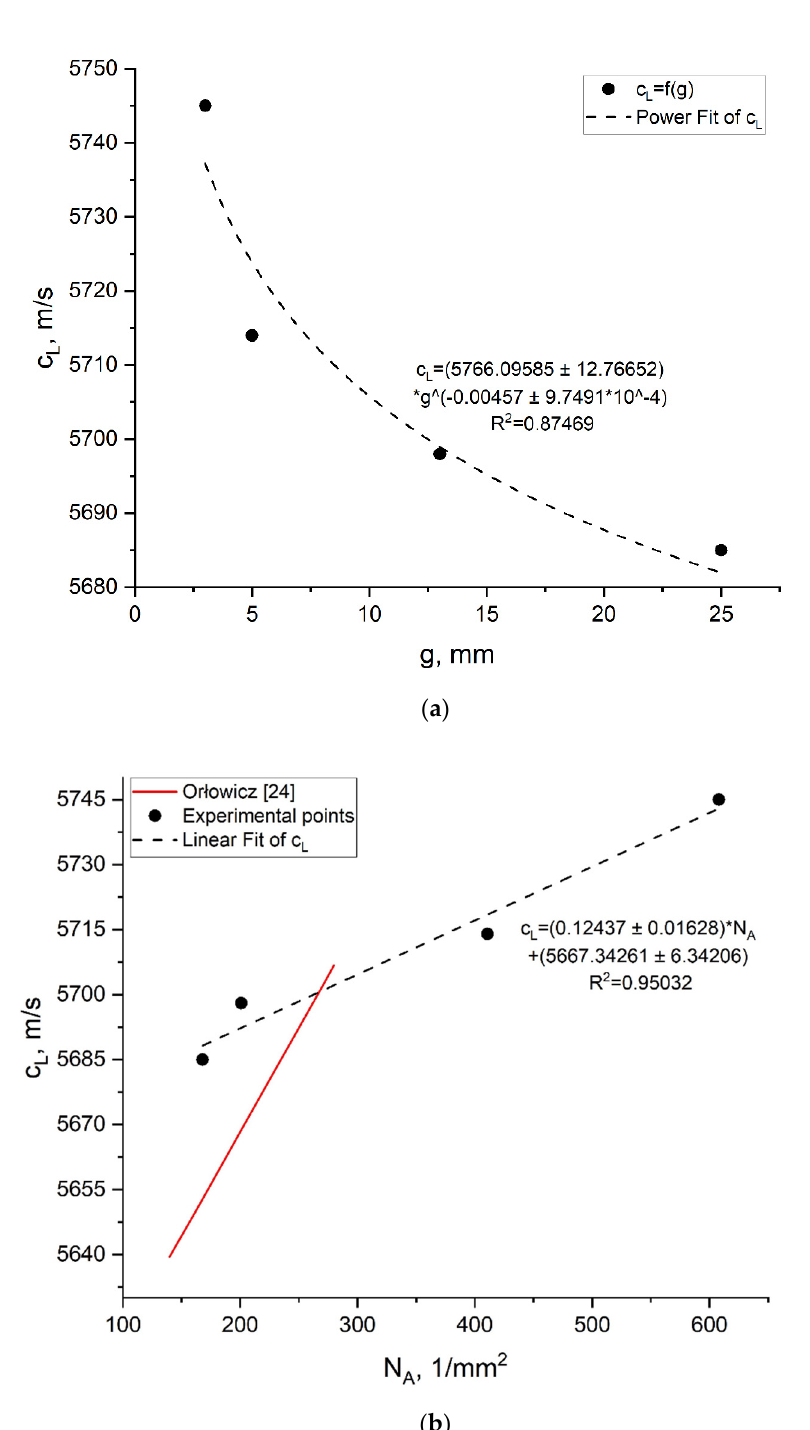
Figure 10. Relationship between longitudinal ultrasonic wave velocity c L and ( a ) wall thickness and ( b ) number of graphite nodules N A. ( b ) number of graphite nodules N